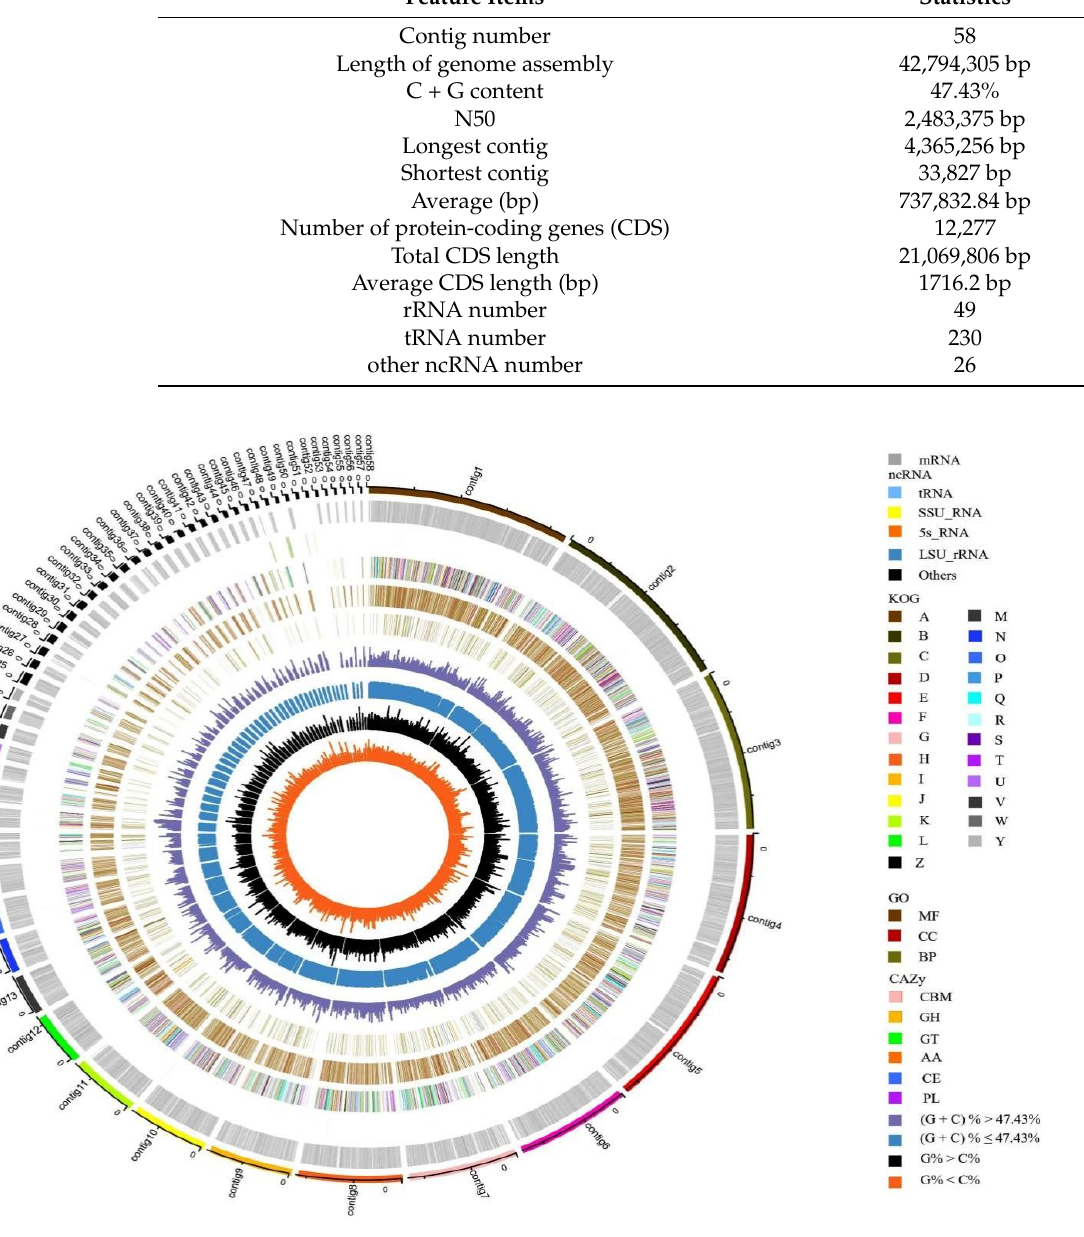
Figure 3. Circular genome map of C. unicolor SP02. From the outside to the center: circle 1: genome contigs; circle 2: mRNA; circle 3: ncRNA; circles 4 to 6: the predicted protein-coding genes by using KOG, GO, and CAZy databases, respectively, where different colors represent different function classifications; circle 7: (G + C) % > 47.43%; circle 8: (G + C) % ≤ 47.43%; circle 9: G% > C%; circle 10 G% < C%.